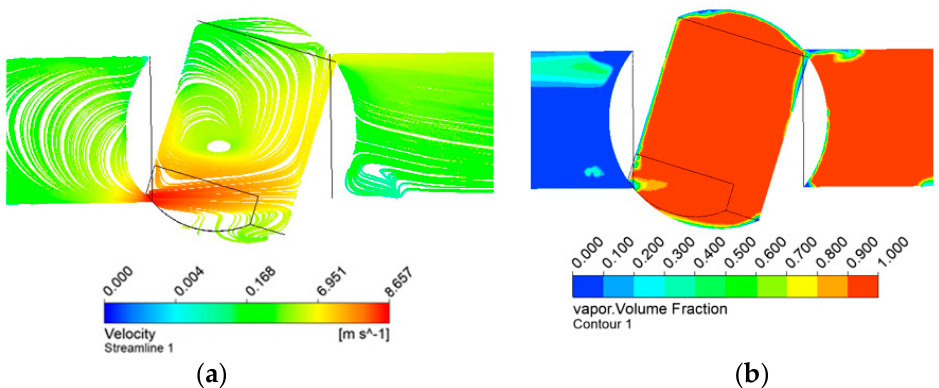
Figure 10. Contour plots of the velocity and vapor volume fraction for a V-port ball valve at an opening rate of 20%: ( a ) velocity of streamlines; ( b ) vapor volume fraction.